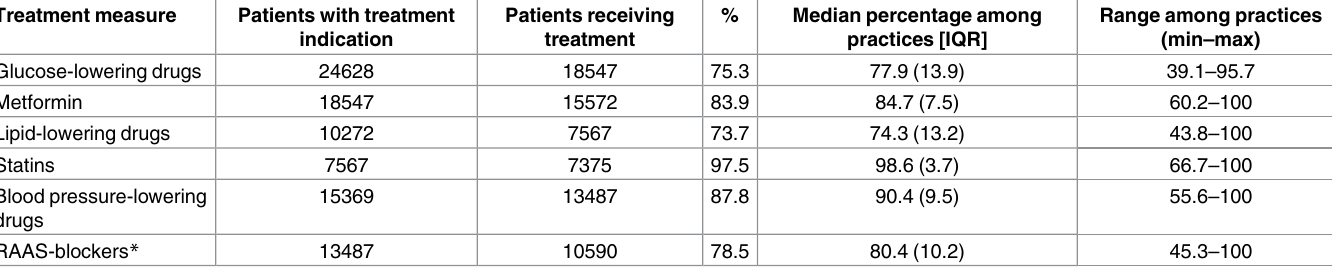
Table 2. Proportion of patients treated and the between practice differences in treatment rate.